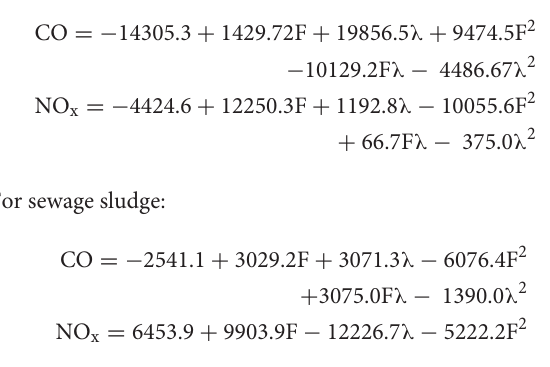
sludge the feed rate had a slight positive effect on CO